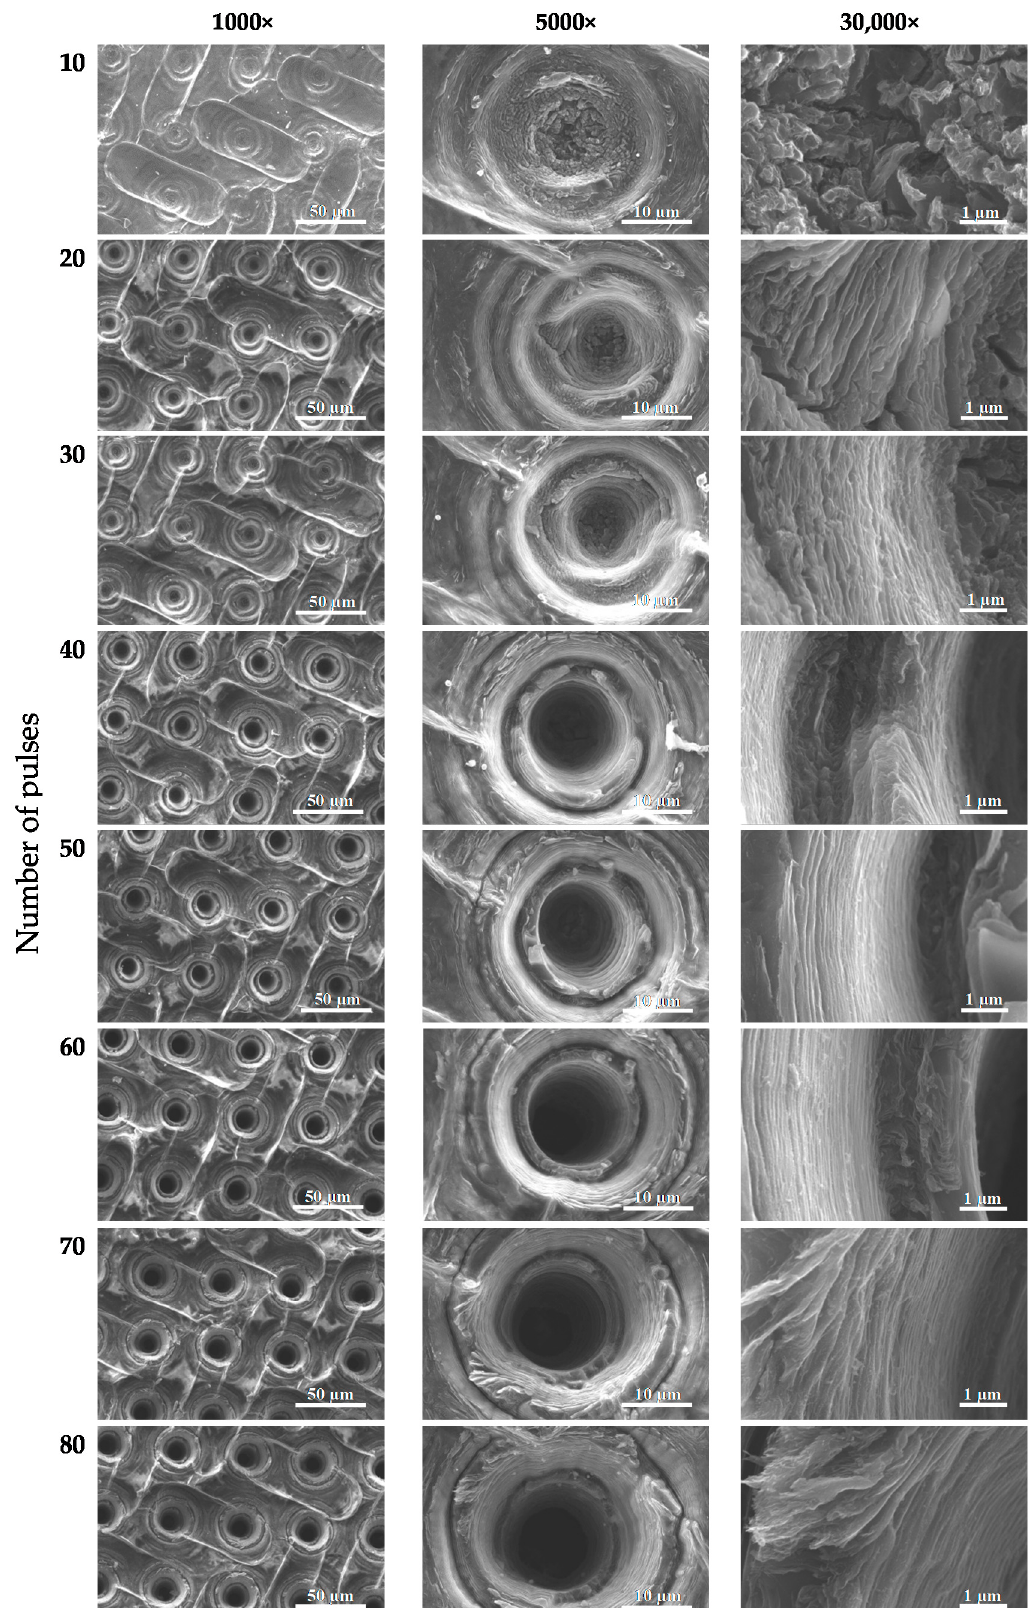
Figure 5. SEM images of the boundary areas of the craters created in graphene paper with a laser ablation method (pulse energy—20 µJ).